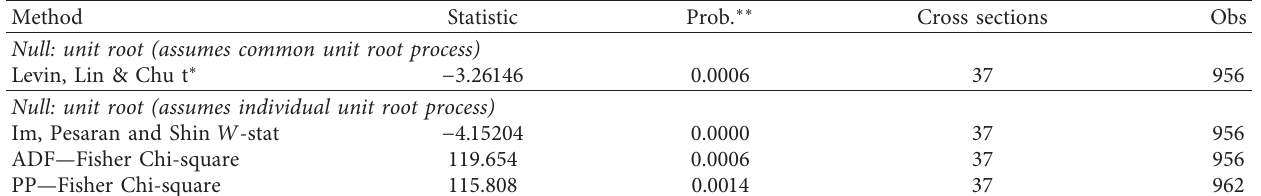
Figure 7: China and US resilience Table 4: Panel unit root test results.